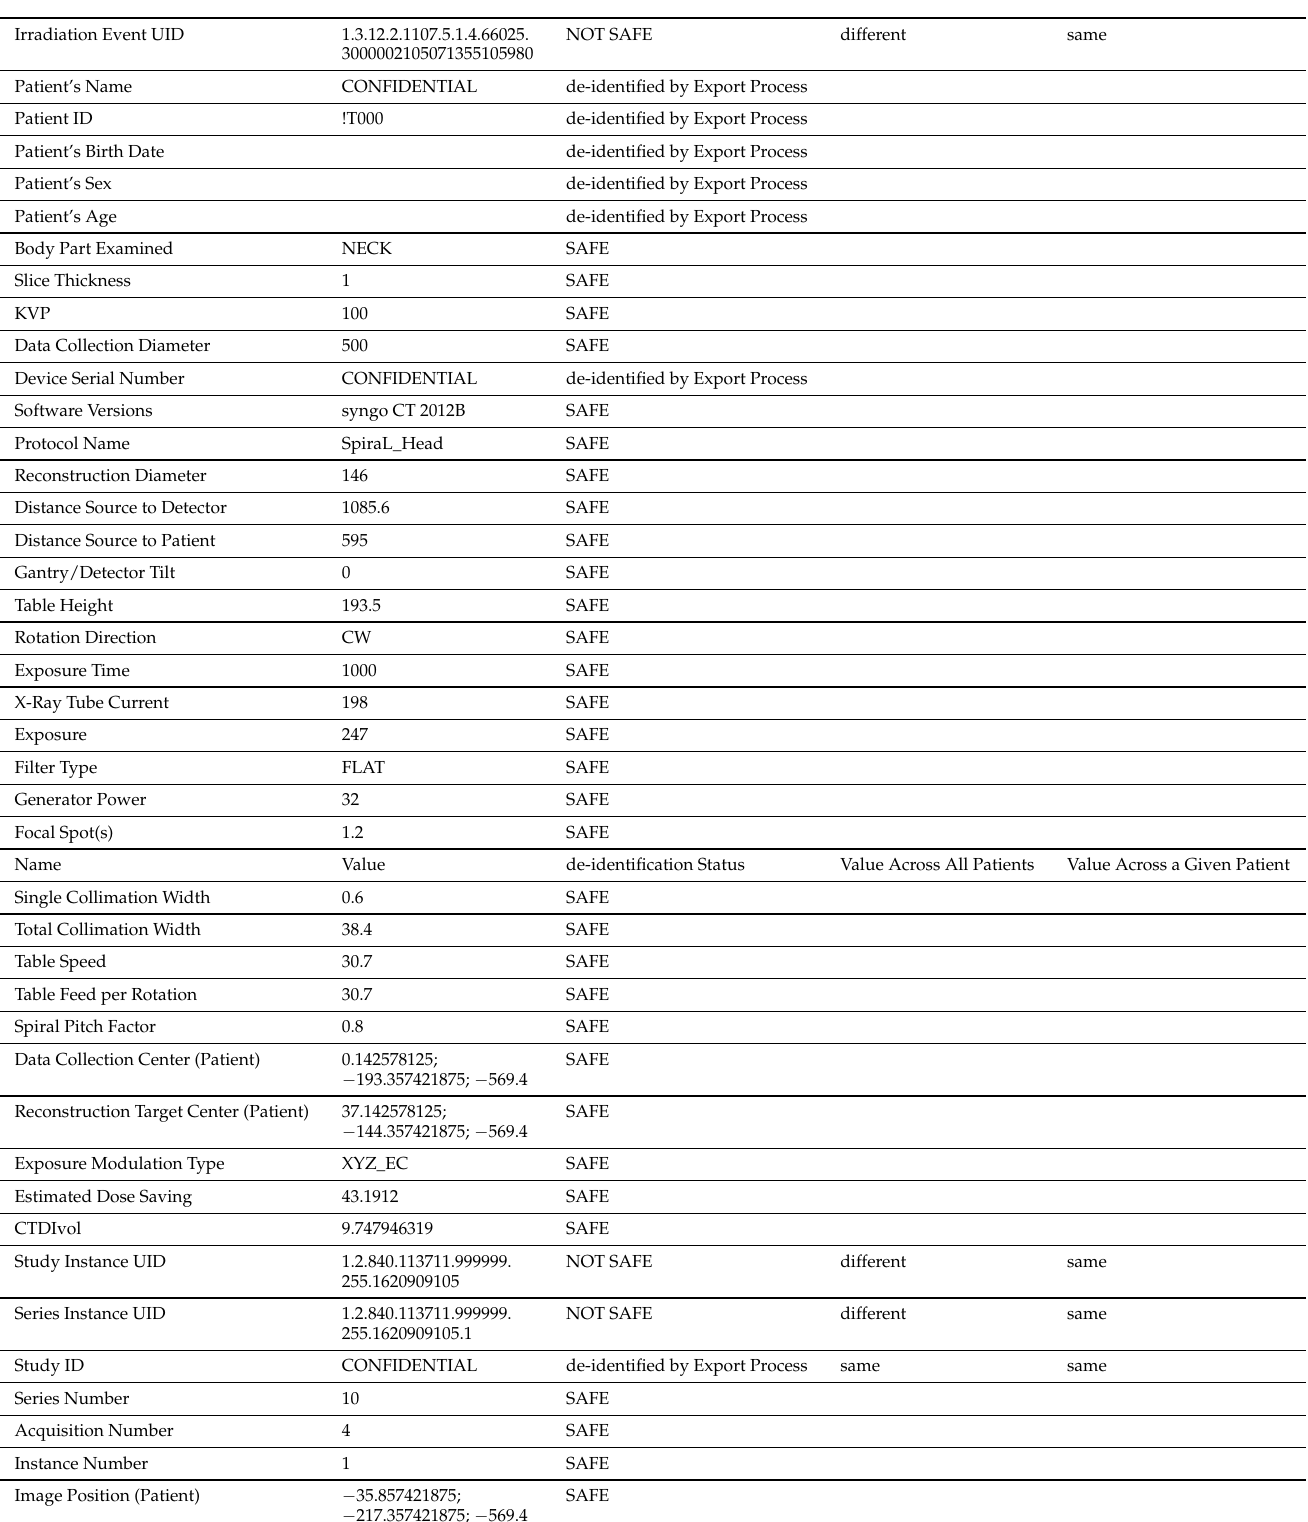
Table A2. Detailed examination of DICOM header (part